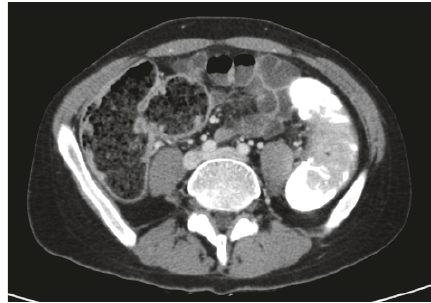
Figure 3: Abdominal CT scan showing GIP the left colon.